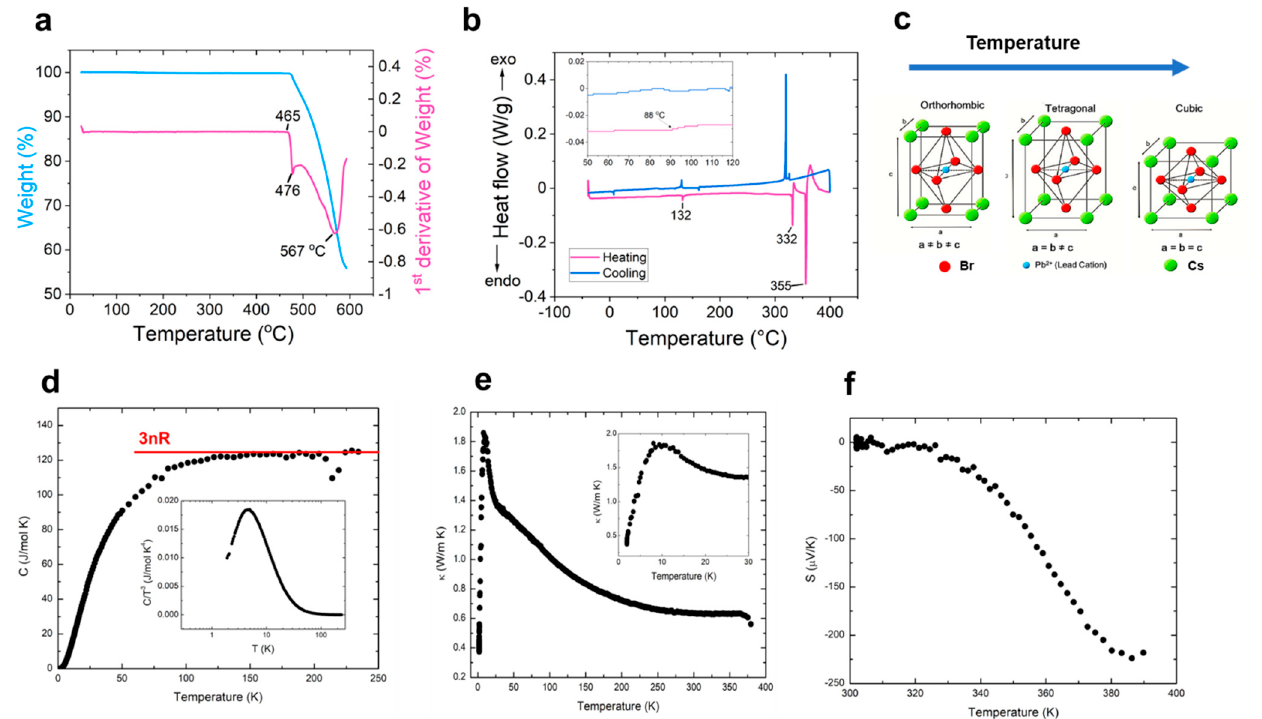
Figure 3. Thermal analysis of CsPbBr 3 . ( a ) TGA; ( b ) DSC; ( c ) schematic of different phases as a function of temperature; ( d ) temperature dependence of the specific heat. Inset: C p /T 3 versus temperature; ( e ) temperature dependence of the thermal conductivity. Inset: low-temperature thermal conductivity; ( f ) Seebeck coefficient versus temperature.